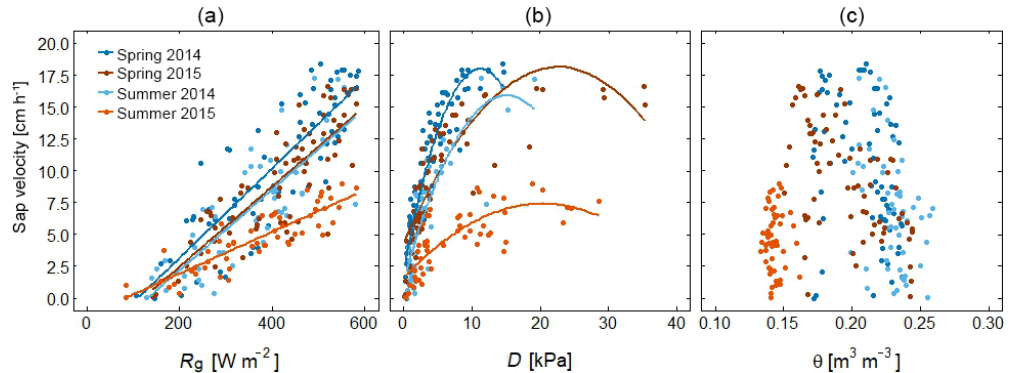
Figure 9. Relationship between sap velocity and meteorological conditions for spring and summer 2014 and 2015 for a beech tree in the schist area. The relationship between mean daily sap velocity and (a) global radiation ( R g ), (b) vapour pressure deficit ( D ), and (c) soil moisture content ( θ ). The regression line is shown in the plot. In summer 2015, sap velocity is low, despite high R g and D .